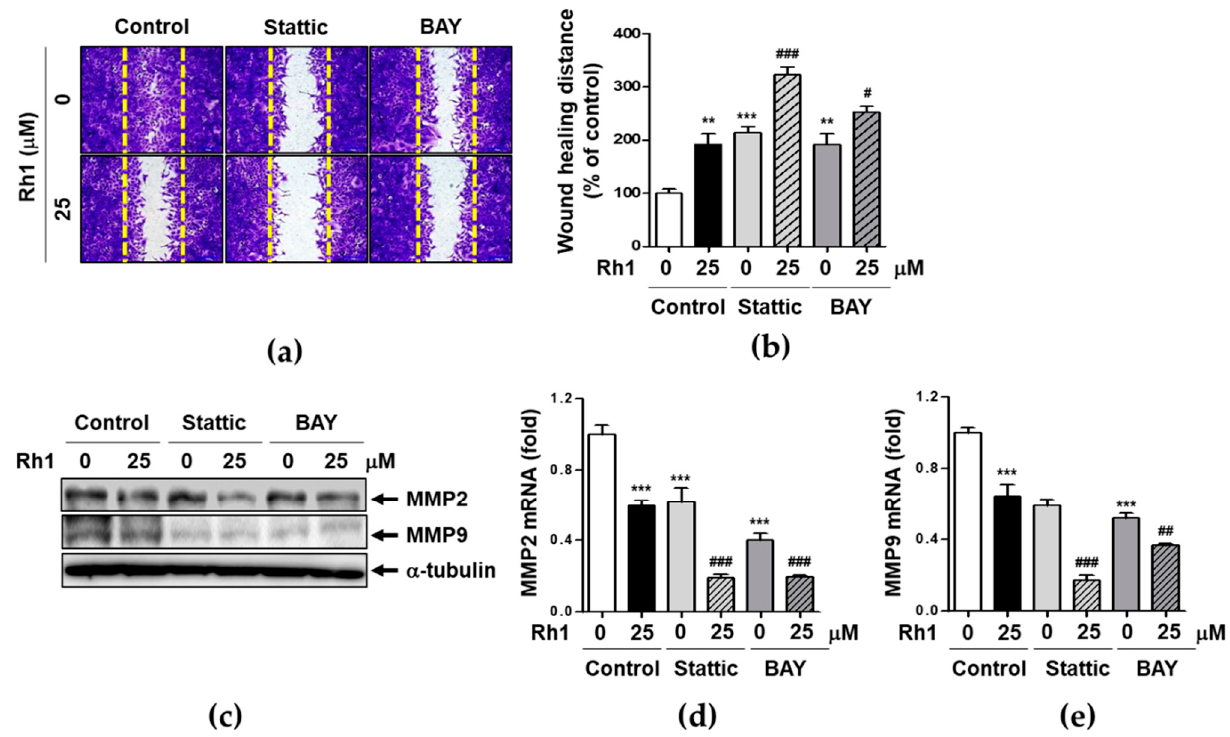
Figure 7. Rh1 inhibits cell migration via down-regulating STAT3/NF- κ B signaling pathway. ( a , b ) MDA-MB-231 cells were grown as a nearly confluent monolayer culture and then scratched using pipette tip. Cells were pretreated with 0.5 µ M stattic or 1 µ M BAY for 1 h followed by treatment with 25 µ M Rh1 for 36 h. After 36 h, cells were fixed, stained with crystal violet, and photographed using an Olympus microscope. The scale bar indicates 200 µ m. ( b ) The migration area was measured using Image J software and indicated as fold changes compared to control (0) sample. ( c ) MDA-MB-231 cells were pretreated with 0.5 μ M stattic and 1 μ M BAY for 1 h followed by treatment with 25 μ M Rh1 for 12 h and whole protein lysates and RNA samples were subjected to western blotting against MMP2 and MMP9 or qRT-PCR ( d , e ) against MMP2 and MMP9. The data are presented as means ± SEM ( n = 3). ** p < 0.01 or *** p < 0.001 compared with control. # p < 0.05, ## p < 0.01 or ### p < 0.001 compared with each inhibitor alone.